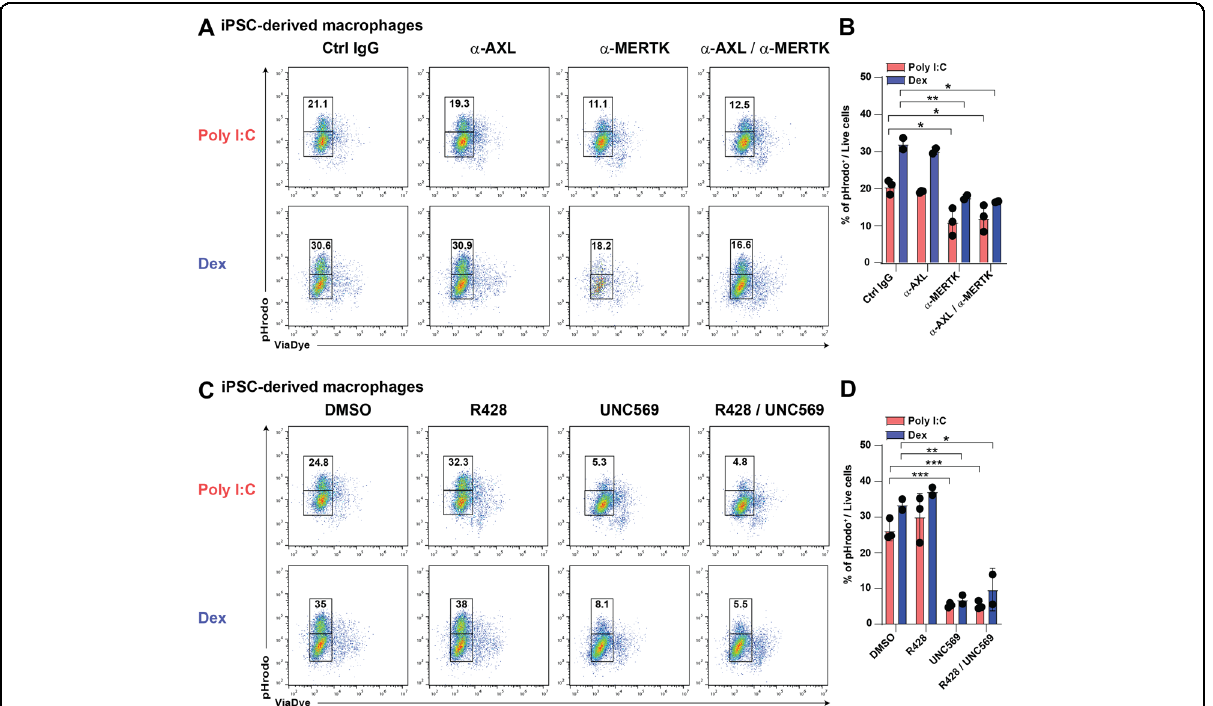
Fig. 5 MERTK kinase activity is critical for efferocytosis in human iPSC-derived macrophages in vitro. A Flow cytometric analysis of efferocytosis in vitro using iPSC-derived macrophages. Macrophages were stimulated with Poly (I:C) or dexamethasone for 24 h prior to the assay. ACs were generated as described and labeled with 50 nM GAS6. Prior to addition of apoptotic cells, macrophages were incubated with indicated antibodies for 30 min. B Frequency of pHrodo + macrophages. Bar graphs show mean with SD and individual samples. C Flow cytometric analysis of efferocytosis in vitro using iPSC-derived macrophages. Macrophages were stimulated with Poly (I:C) or dexamethasone for 24 h prior to the assay. ACs were generated as described and labeled with 50 nM GAS6. Prior to addition of apoptotic cells, macrophages were incubated with indicated inhibitors for 30 min. D Frequency of pHrodo + macrophages. Bar graphs show mean with SD and individual samples. Data were representative of at least three individual experiments with technical